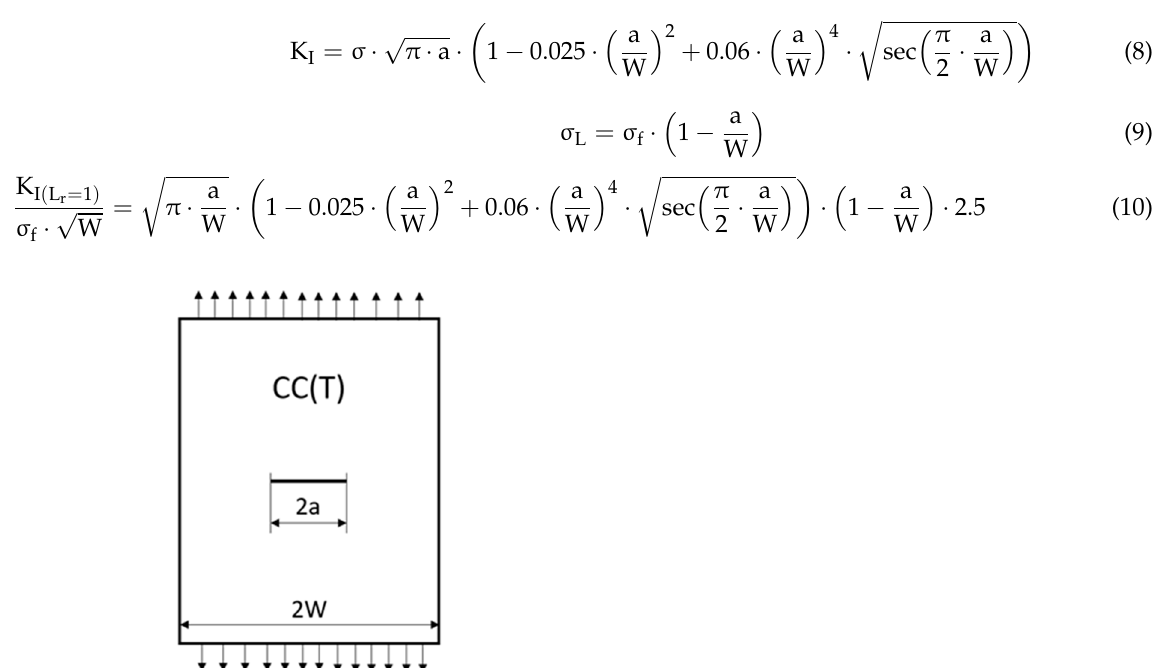
Figure 1. Definition of CC(T) specimen dimensions. The dimensions 2a and 2W are the crack length and specimen width, respectively.